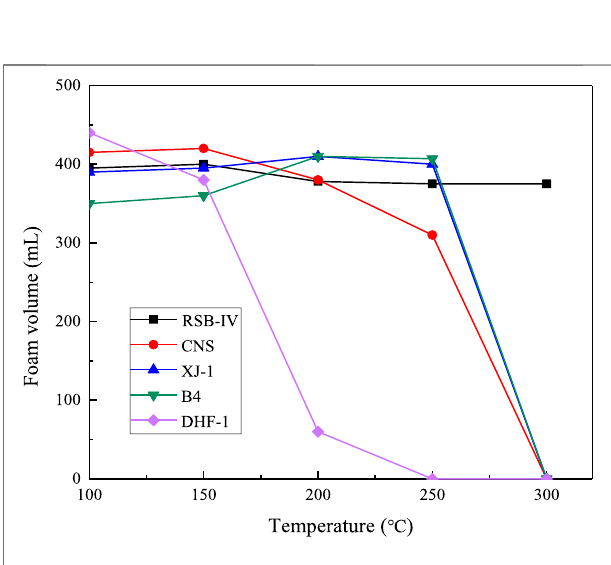
FIGURE 4 | Variation of foaming volume with temperature (Concentration was 0.5